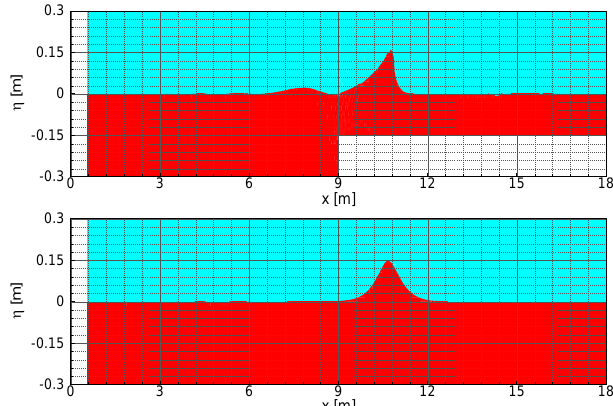
Figure 13. Compare the snapshots of wave profiles at t = 7.2 s.